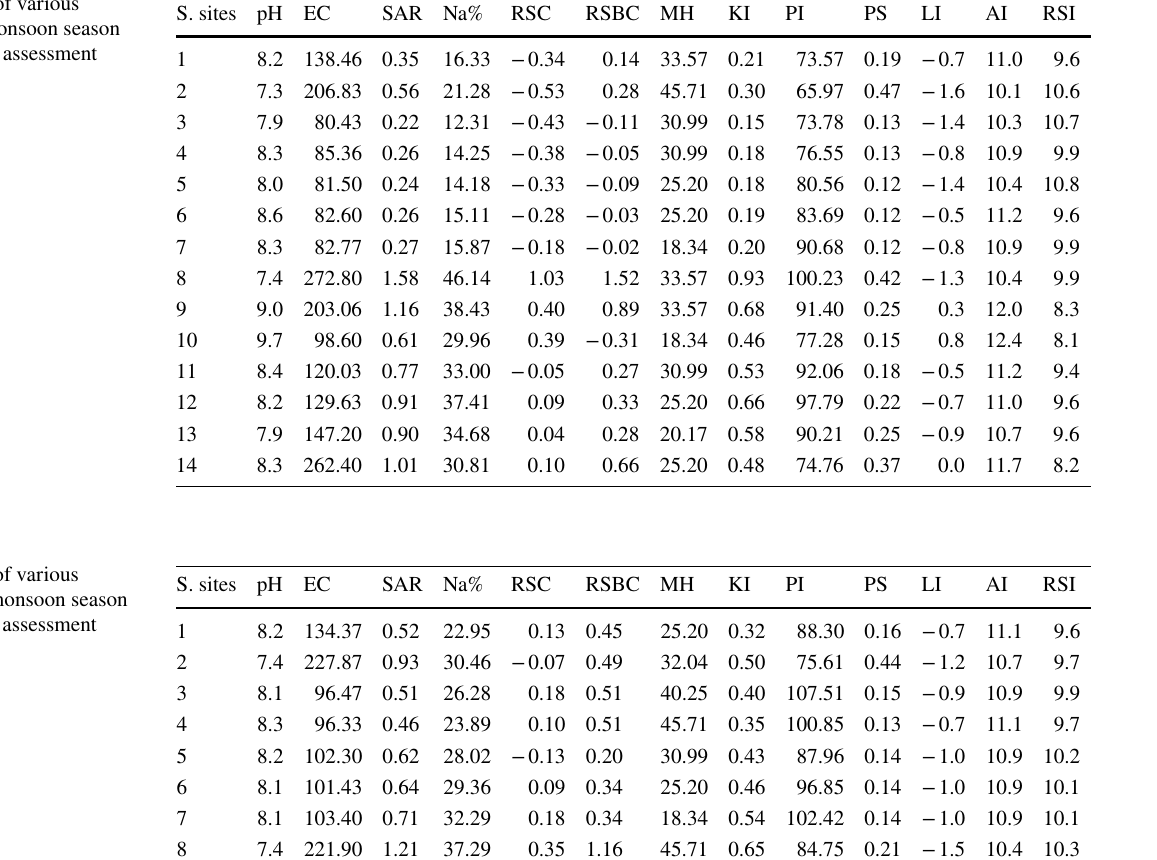
indices of pre-monsoon season for water quality assessment